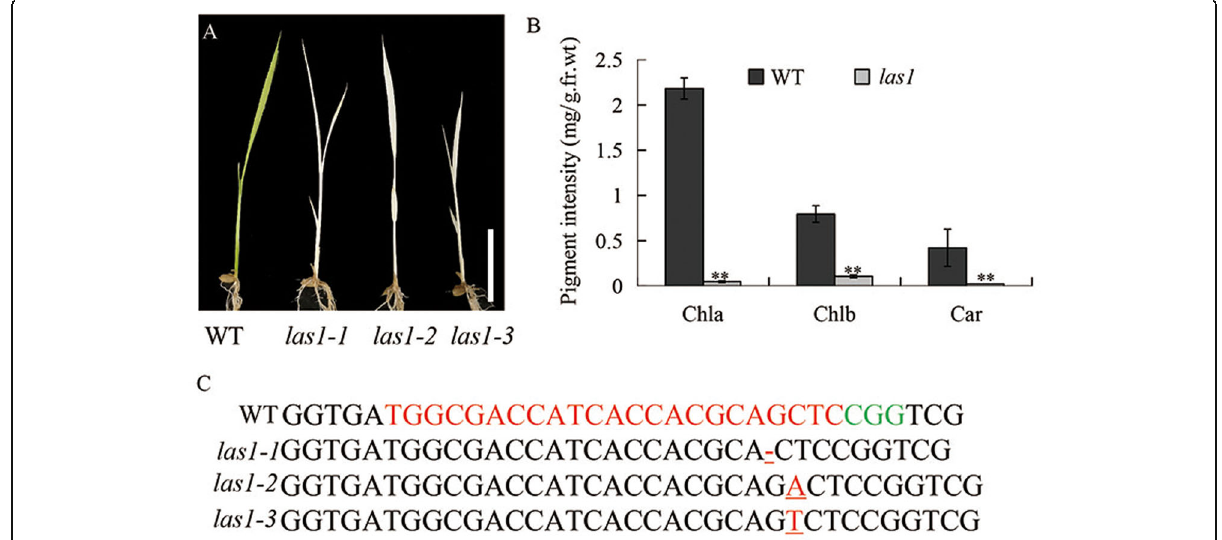
Fig. 1 The phenotype and pigment contents of wild type and las1 . a Morphology of wild type (WT) and las1 seedling (Bar = 5 cm). b Pigment contents of WT and las1 seedlings. Values represent the mean ± SD of three biological replicates. ** p < 0.01. c Sequence confirmation of the LAS1 mutation. The 23-nt target sequence of the Cas9/sgRNA complex is underlined in red